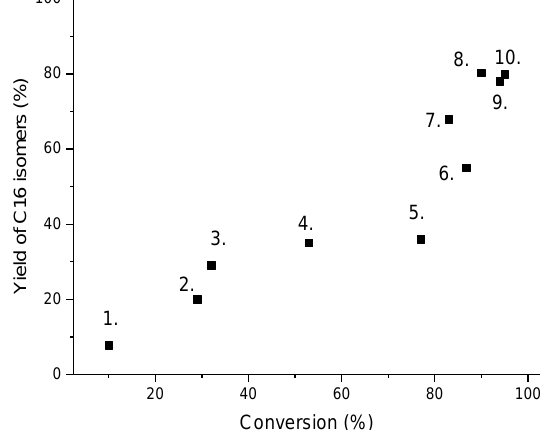
Figure 5. The yield of C16 isomers as a function of conversion. Notation: 1. Pt-H-Beta, 30 bar, 220 ◦ C [22], 2. Pt-H-ZSM-23 (dual templated), 300 ◦ C, 40 bar, volumetric ratio of H 2 /feed 600 L/L [23], 3. Pt-H-ZSM-23, 270 ◦ C, 40 bar, volumetric ratio of H 2 /feed 600 L/L [19], 4. Pt-Al-Si, 310 ◦ C, 30 bar, molar ratio of H 2 /feed 10 [15], 5. Pt-Al-H-Beta (Si/Al ratio 80), 290 ◦ C, 75 bar, WHSV of 1.3 hr − 1 [10], 6. Pt-Al-MCM-41, 200 ◦ C, 20 bar, molar ratio of H 2 /feed pf 4 [24], 7. Pt-ZSM-23, 260 ◦ C, [13], 8. Ba-Pt-ZSM-12, 295 ◦ C, 60 bar [12], 9. Pt-H-Beta (Si/Al 26) 220 ◦ C, 30 bar, molar ratio of H 2 /feed 20 [16], 10. Pt-Beta-Al 2 O 3 , 220 ◦ C, 30 bar, molar ratio of H 2 /feed of 20